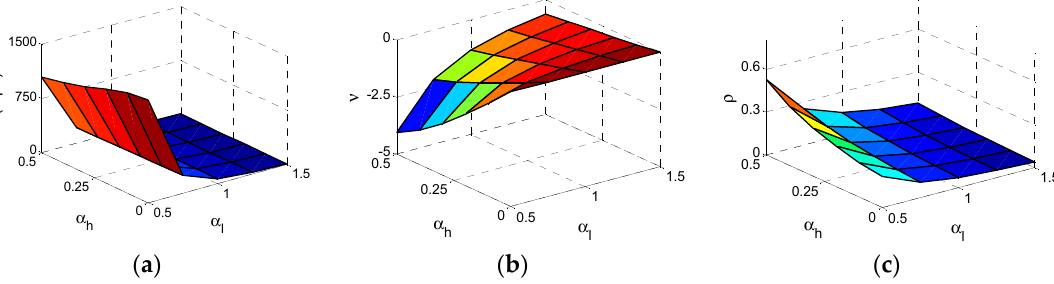
Figure 5. The Surfaces of effective properties for Type A cell: ( a ) effective Young’s modulus E ; ( b ) effective Poisson ratio v ; ( c ) relative density ρ .